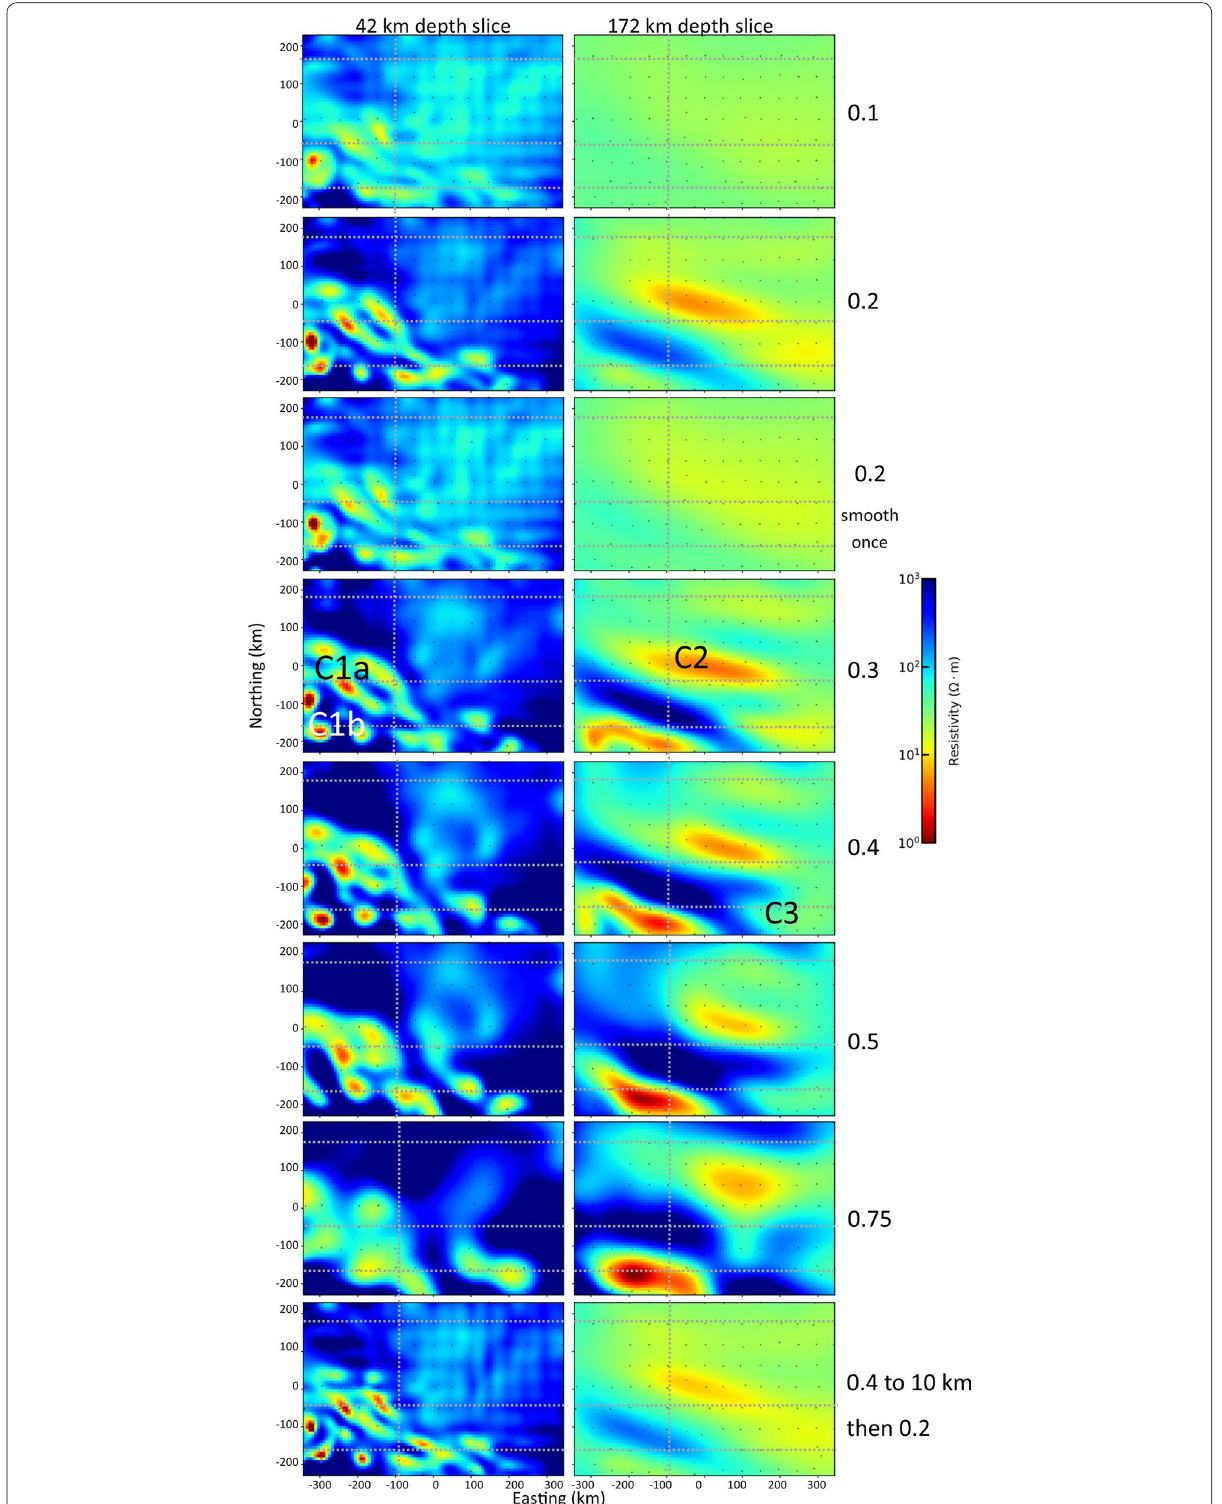
Fig. 12 Each row contains two electrical resistivity depth slices at 42 and 172 km for one covariance test. The eight rows correspond to the eight covariance tests mentioned including homogeneous covariance across the model of 0.1, 0.2, 0.3, 0.4, 0.5, 0.75 and 0.4 down to 10 km then 0.2 at greater depths. The grey dashed lines show the locations of the cross sections in Fig.13. The location of the MT sites inverted is shown by black